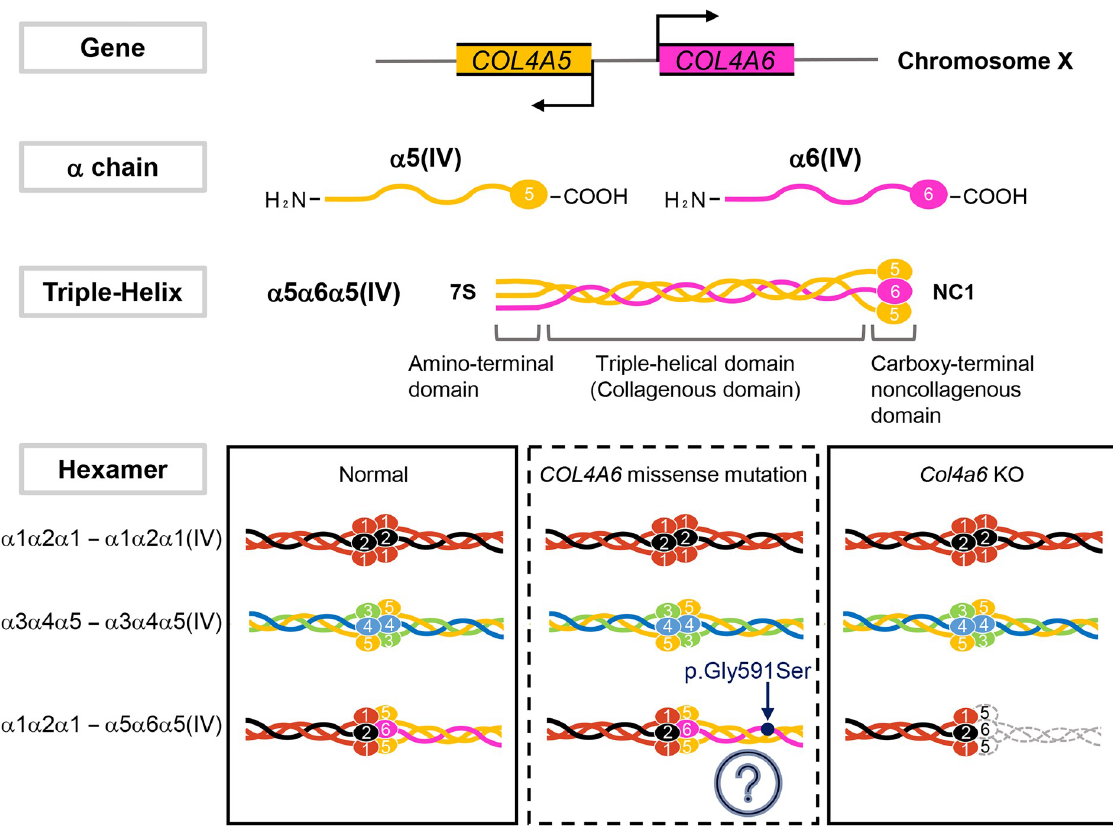
Fig 1. Schematic view of the gene structure and assembly of collagen IV. The COL4A6/Col4a6 gene is located on the X chromosome and paired with COL4A5/Col4a5 in a head-to-head manner. COL4A1/Col4a1 and COL4A2/Col4a2 , and COL4A3/Col4a3 and COL4A4/Col4a4 pairs are located in a head-to-head manner on their respective chromosomes (not shown). Each chain comprises a 400 nm long triple-helical domain, which contains many interruptions in the Gly-X-Y repeated sequence. The globular noncollagenous domain (NC1) is located at the C-terminal end, while the 7S domain is at the N-terminal end. Three α chains assemble the triple-helical molecule (triple-helix). The heterotrimers extracellularly form a hexamer. α 1 α 2 α 1(IV)and α 5 α 6 α 5(IV)bind to each other through the NC1 domain [ α 1 α 2 α 1- α 5 α 6 α 5 (IV)] and the 7S domains (not shown), which facilitates their assembly to a higher-ordered supra structure. α 1 α 2 α 1(IV)is widely distributed, whereas α 3 α 4 α 5(IV)and α 5 α 6 α 5(IV)distribution is tissue specific [7–9, 12]. In Col4a6 KO mice, the loss of α 6(IV) chain expression inhibits the formation of the α 5 α 6 α 5(IV) heterotrimer. This study showed that the phenotypes of the auditory system in Col4a6 KO mice were distinct from those of individuals with the COL4A6 missense mutation c.1771G > A, p.Gly591Ser. The presence of the mutant protein α 6(IV) chain and/or α 5 α 6 α 5(IV)may induce deleterious effects on the cochlea. The pathogenesis involved in congenital hearing loss warrants further investigations.